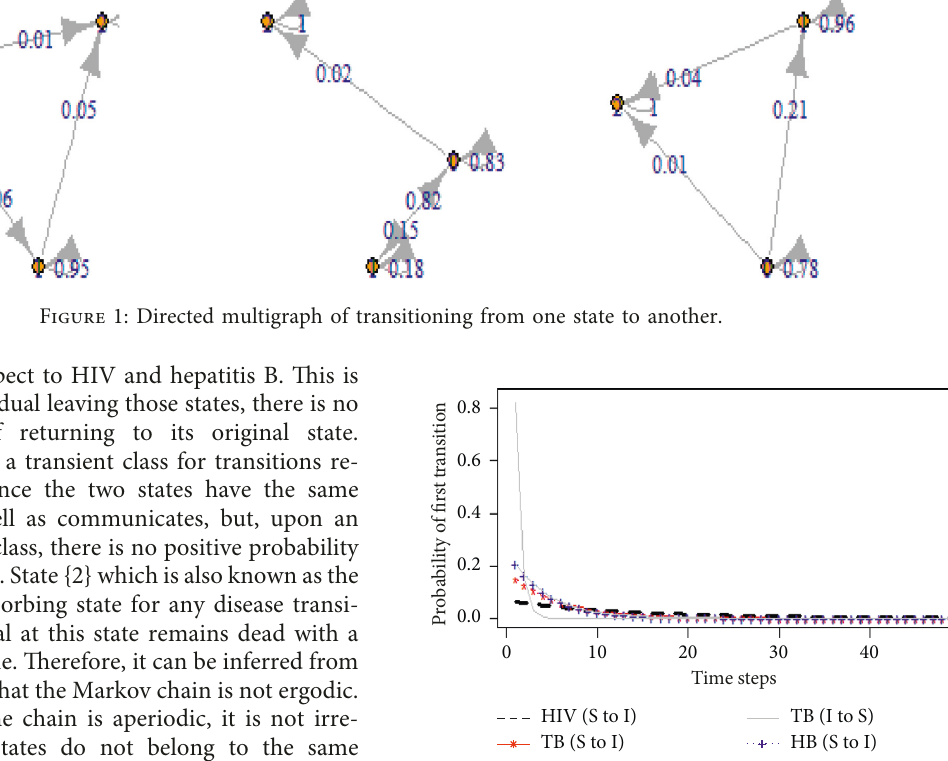
Figure 2: Probability of first infection and